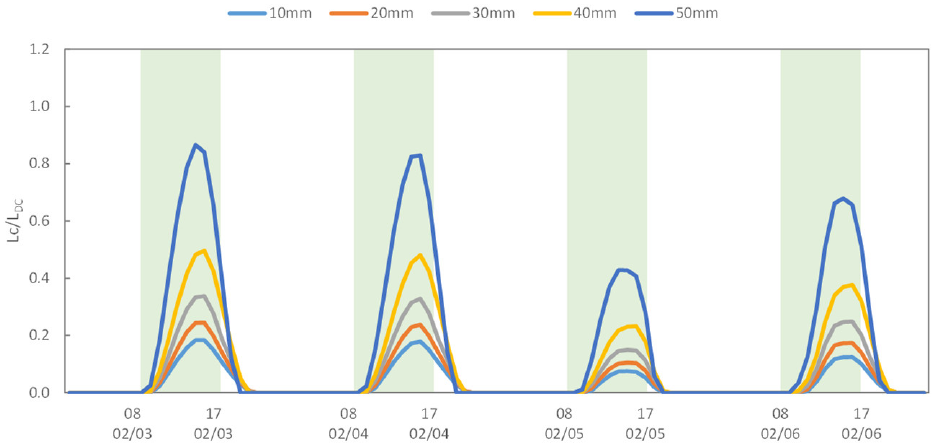
Figure 10. Operating efficiency of the PCM during the ventilation season.